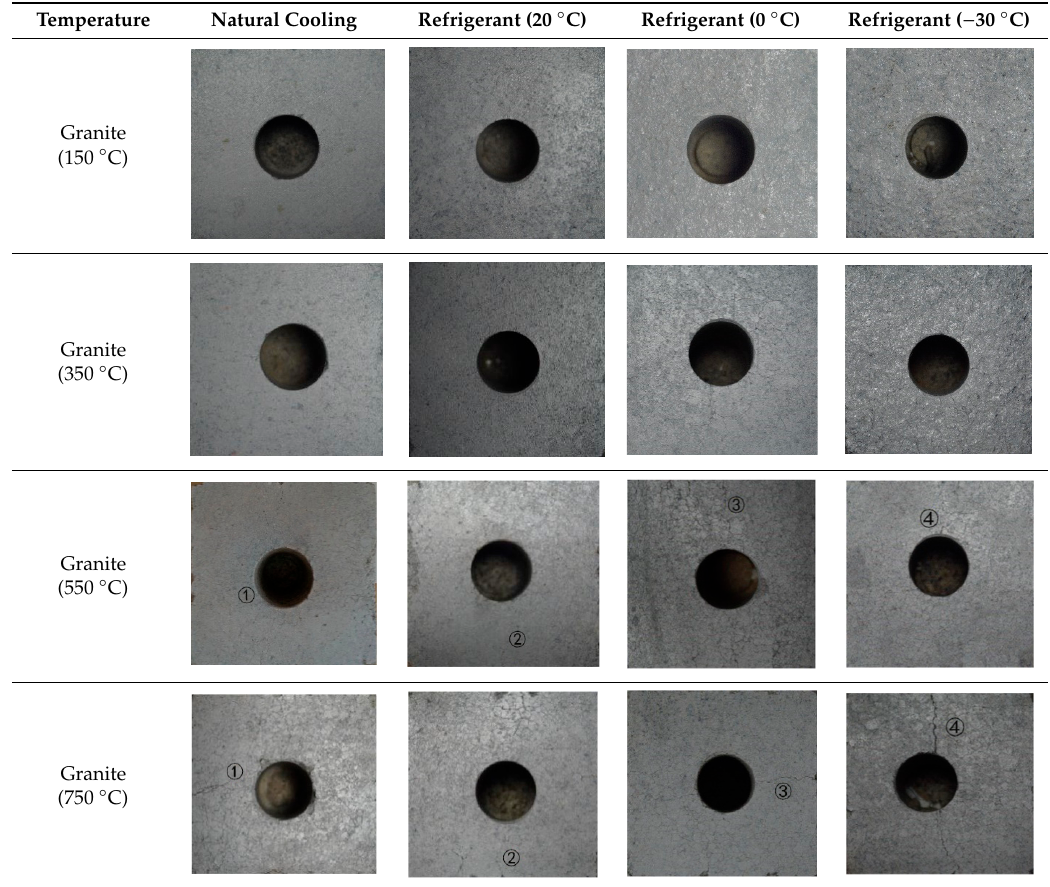
Table 3. Comparisons of samples surface cracking features under different cooling shocks.